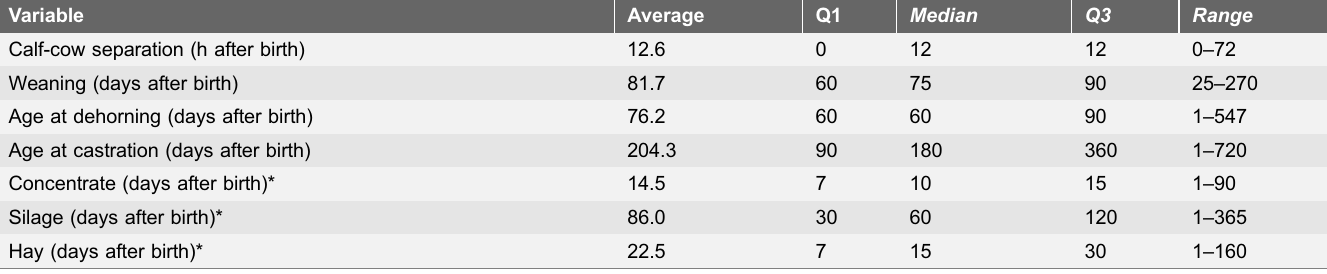
Table 3. Timing of calf management practices, as reported by smallholder dairy farmers of Santa Catarina State, Brazil (n 5